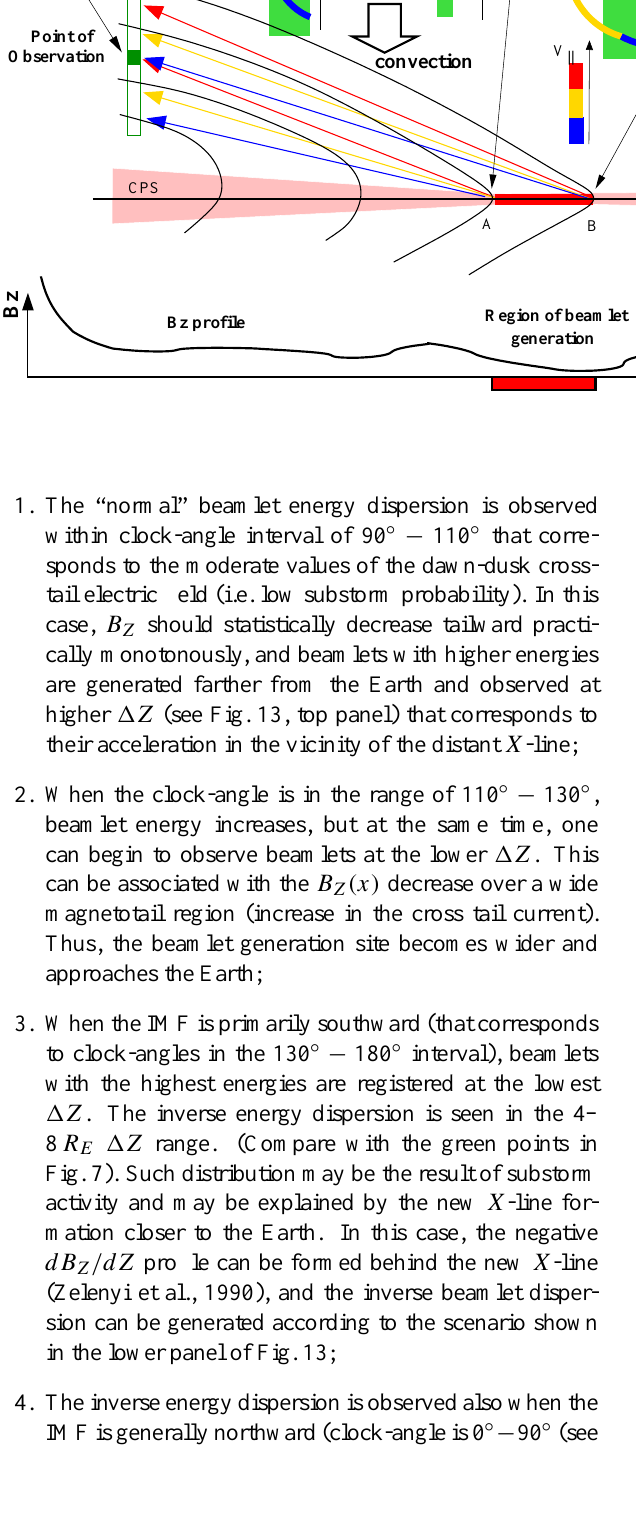
Fig. 11. The sketch showing the forma- tion of the beamlet. The horizontal red bar shows the possible beamlet gener- ation region. Each point of this region generates a ring-like distribution. Due to the convection filter, only specific V || can reach the point of observation (green rectangular). Different color arcs in the distributions show different V || . Color arrows show the appropriate tra- jectories of varying V || . The observed distribution function is the collection of particles accelerated at the point A with the V || in the “V1” band, and particles accelerated in the point B with V || in the “ V 2”